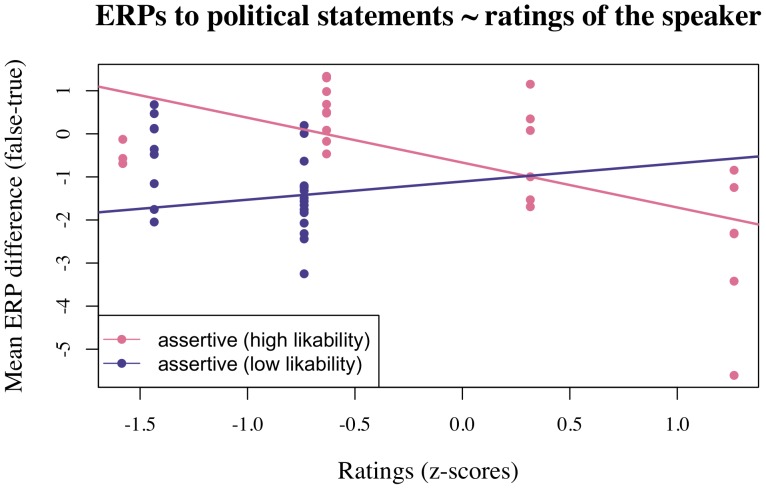
Effect of by-participant assertiveness ratings for the political speaker on the TRUE-FALSE effect for political statements in the left-anterior region in Experiment 1.Higher N400 amplitudes correlated with higher assertiveness judgements for those participants who judged the political speaker to be of above-median likability.